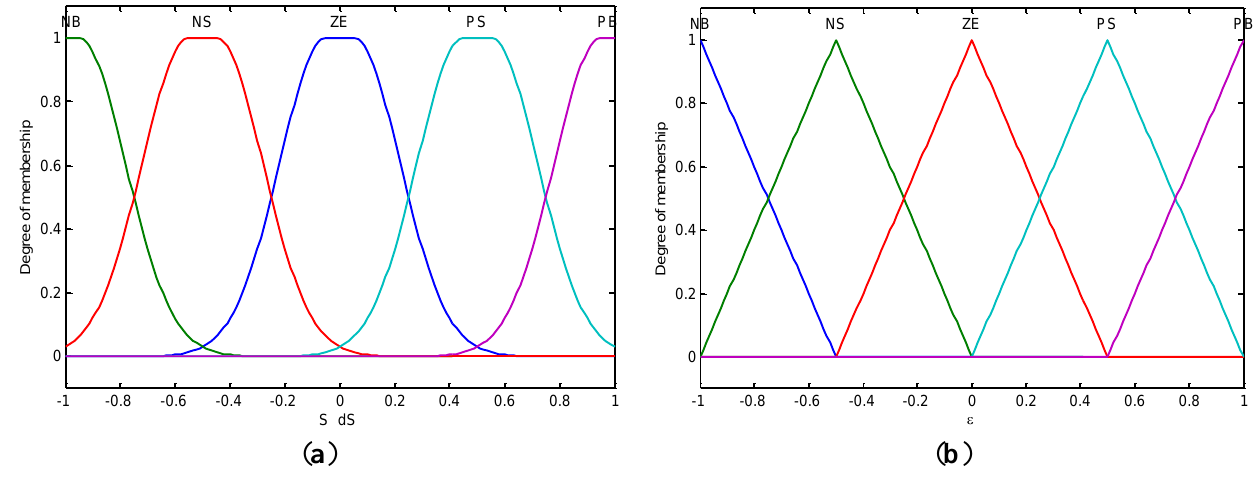
Figure 6. Membership functions for the: ( a ) inputs and ( b ) outputs.